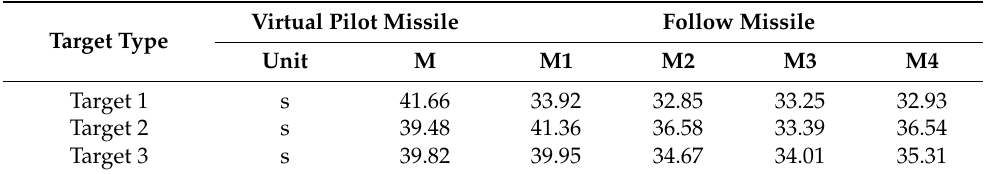
Table 3. Impact time of APN